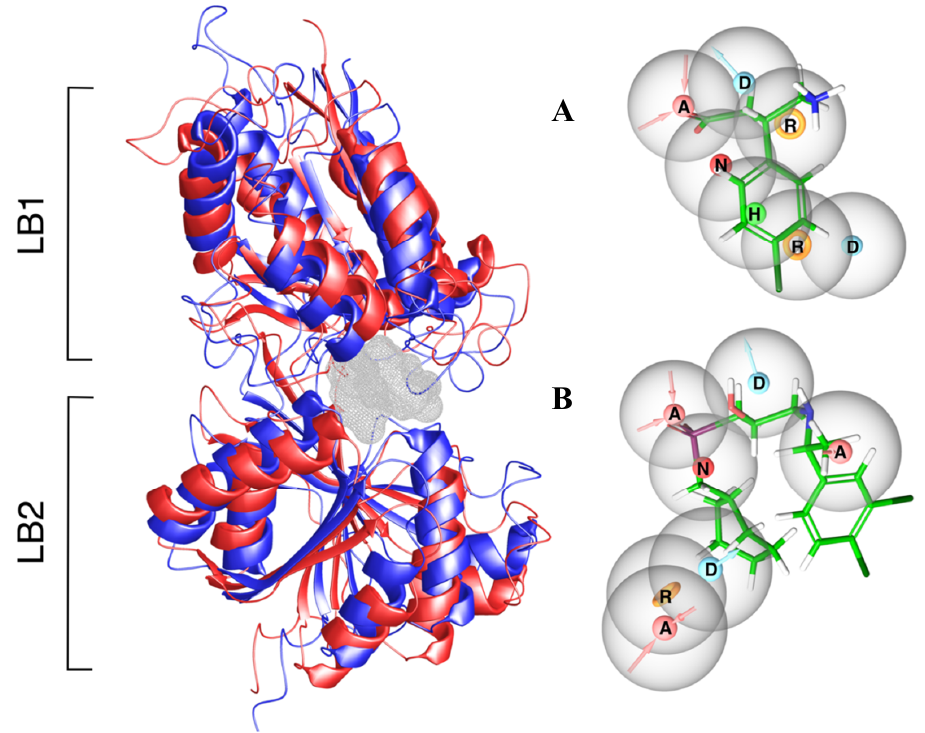
Figure 2. The X-ray crystal structure of the GABA B -R VFT superimposed in the active (blue) and inactive (red) conformation with the binding pocket cavity showed in grey mesh. ( A ) The e-Pharmacophore of the agonist-induced active VFT conformation displayed with baclofen ( B ) The e-Pharmacophore of the inactive antagonist-induced VFT conformation with the antagonist CGP54626. Both e-Pharmacophores are shown in the same view corresponding to their orientation in the binding pocket cavity (left) with LB1 up and LB2 down. Feature abbreviations; hydrophobic feature: H, hydrogen bond acceptor feature: A, hydrogen bond donor feature: D, aromatic feature: R, positively charged feature: P, and negatively charged feature: N.